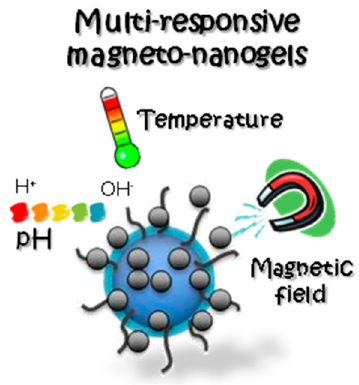
Figure 2. Schematic representation of a multi-stimuli nanogel particle with encapsulated magnetic nanoparticles sensitive to pH, temperature, and magnetic field. (Reprinted with permission from reference [54]. Copyright 2016 Wiley).